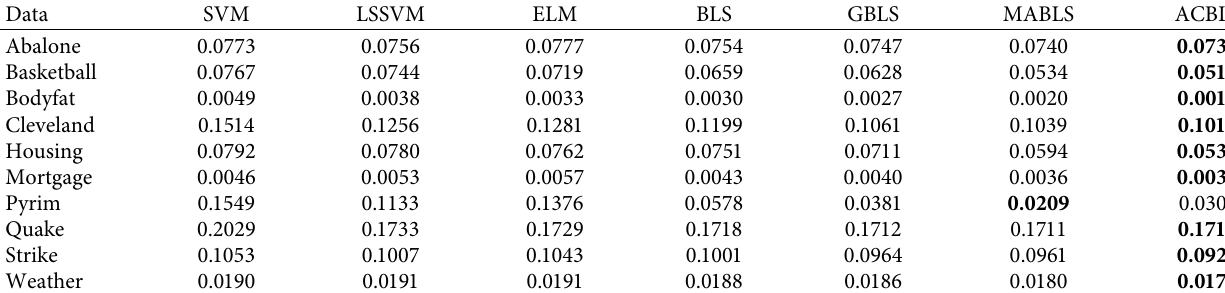
Table 12: RMSE testing results for different